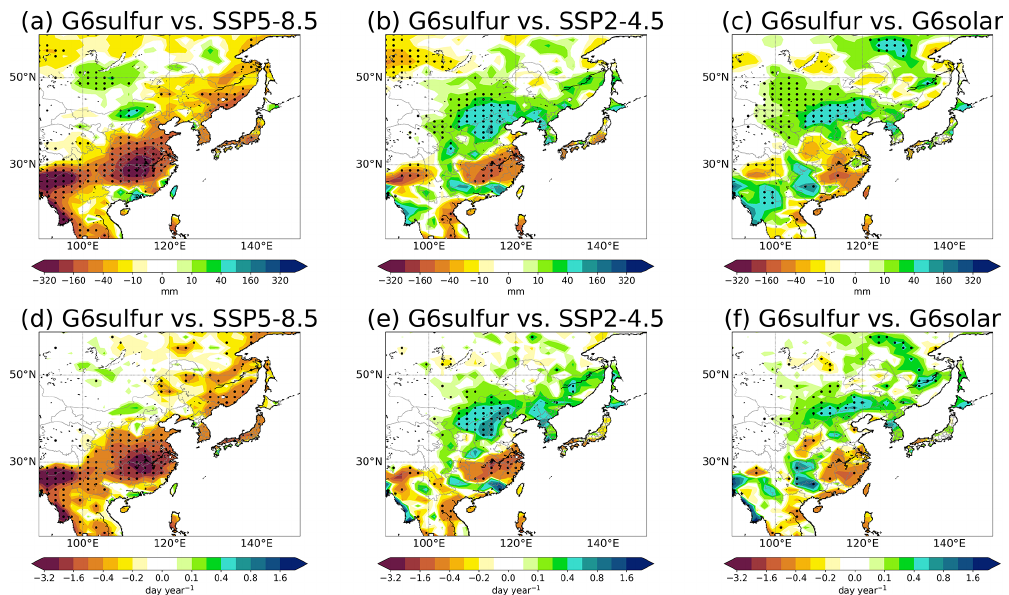
Figure 11. Differences in annual accumulation of AR-related precipitation (a–c) and heavy rain events (d–f) for the future period of 2071– 2100 between G6sulfur and SSP5–8.5 (a, d) and SSP2–4.5 (b, e) and G6solar (c, f) . Stippling indicates differences that are statistically significant at a confidence level > 95% ( p value < 0.05 based on Student’s t